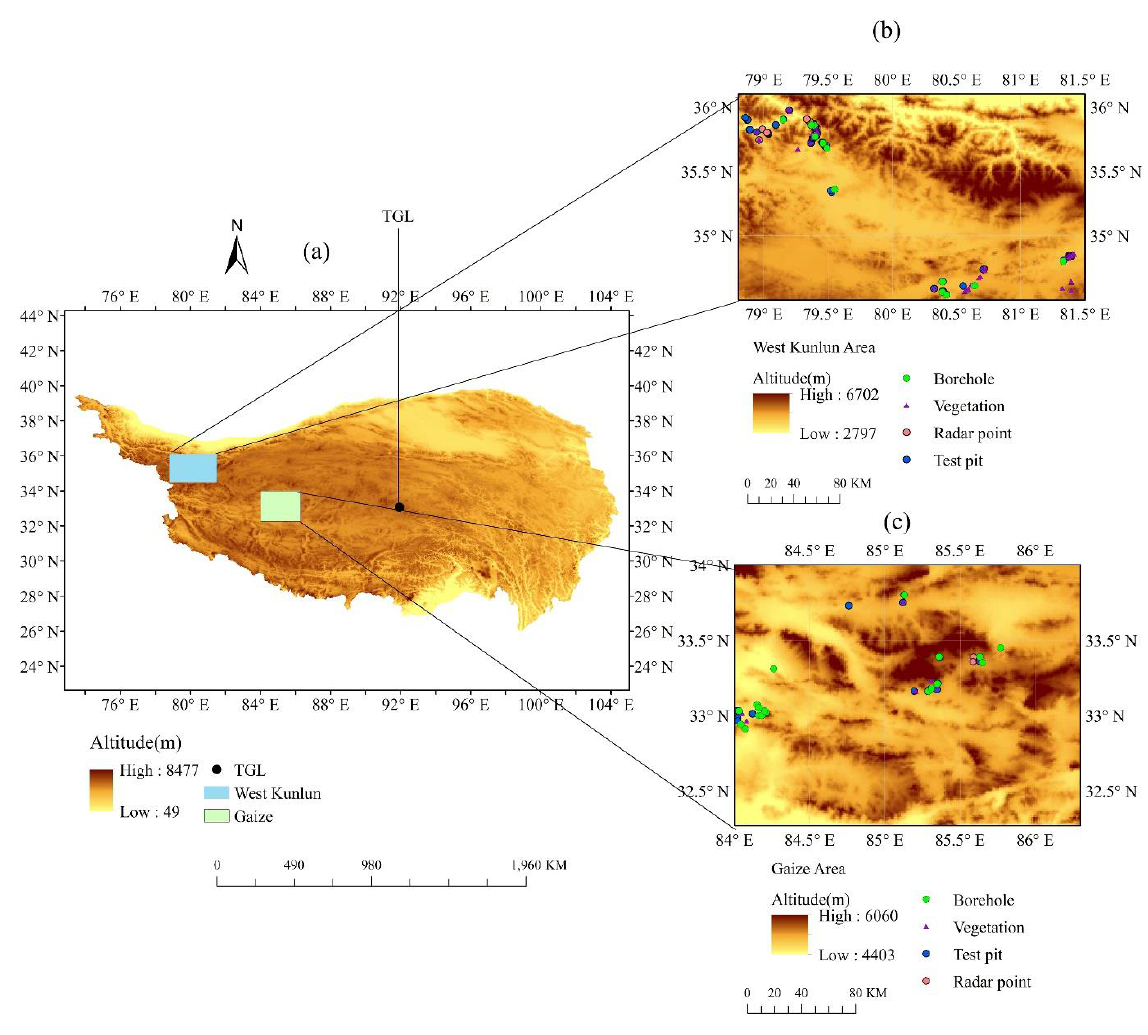
Figure 1. ( a ) Altitude of the QTP and locations of the TGL station, Gaize area, and West Kunlun area; ( b ) altitude and sampling sites of the Gaize area; ( c ) altitude and sampling sites of the West Kunlun area.